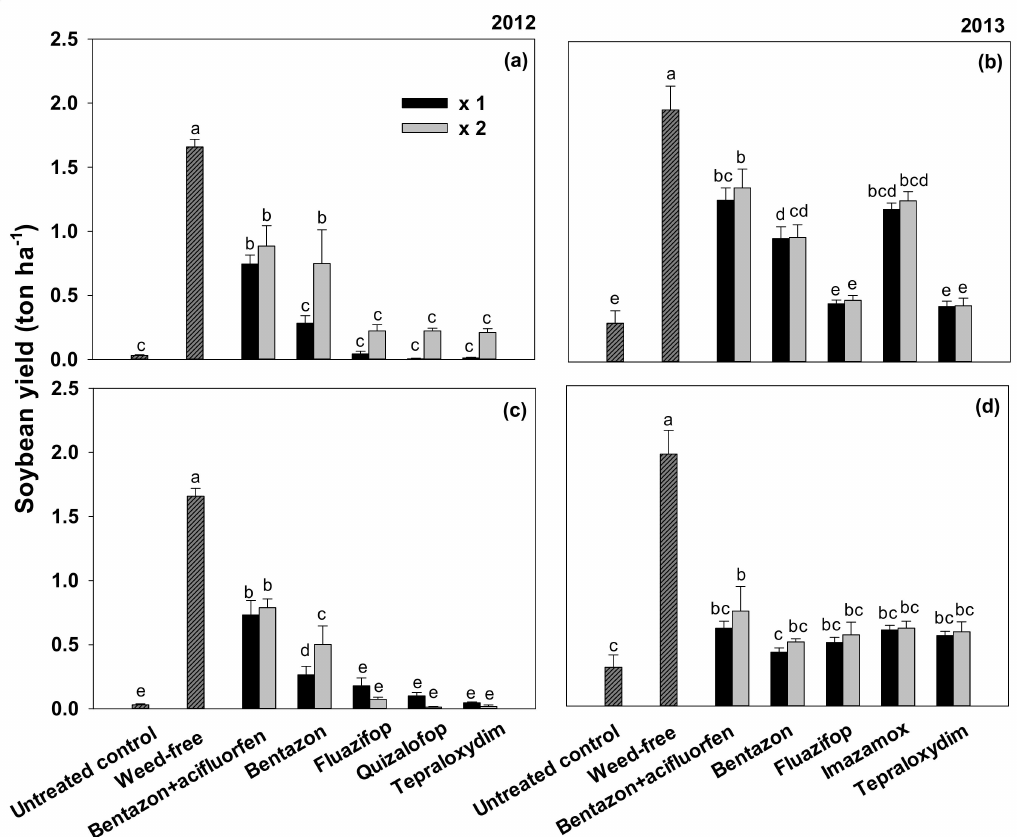
Figure 2. The seed yields (t ha − 1 ) of soybean with a single application of post-emergence (POST) herbicides made at either 30 DAS ( a , b ) or 60 DAS ( c , d ) in 2012 ( a , c ) and 2013 ( b , d ). The vertical bars represent the SE of the mean of three replicates. Means with the same letter are not significantly di ff erent by Duncan’s multiple range test (DMRT) at p <